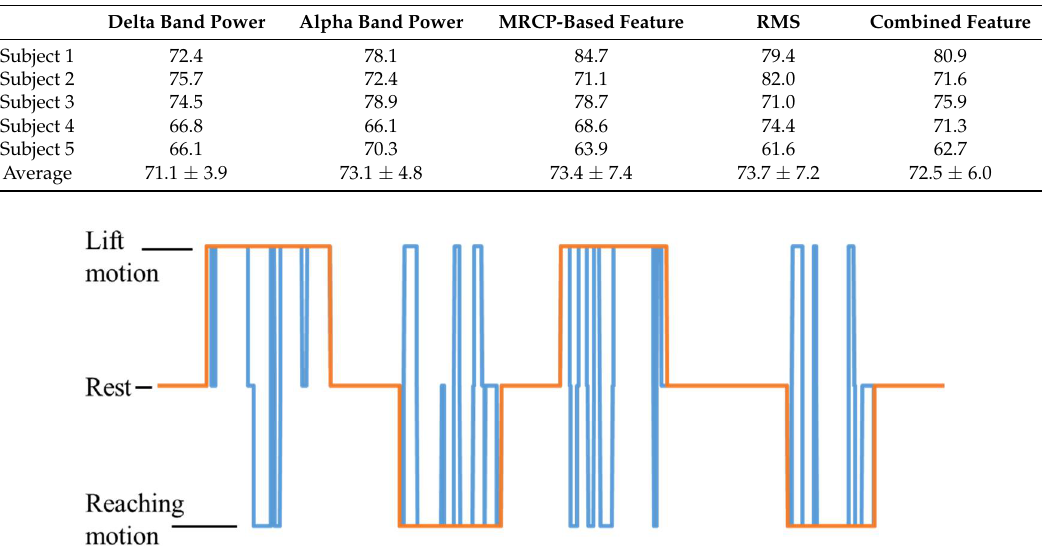
Figure 7. Prediction from the system with MRCP for Subject 1 (1 = lifting motion, −1 = reaching motion, 0 = rest, blue line = prediction, orange line = subject motion).